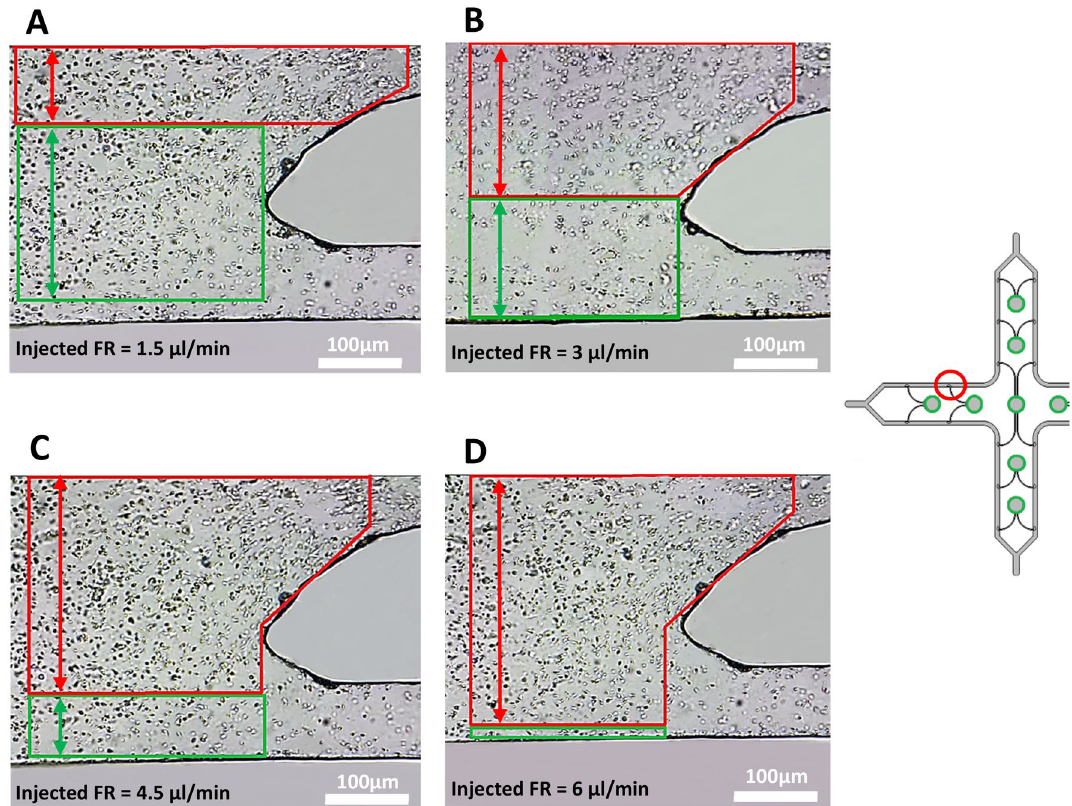
Figure 4. Inertia zone (red) vs. Rheotaxis zone (green). As the injected flow rate increases from 1.5 μl/min to 6 μl/min, the inertia zone prevails over the rheotaxis zone and causes it to eventually fade at 6 μl/min. This observation shows that the rheotaxis zone is not a fixed area inside the microchip and highly depends on the flow rate injected into the device.